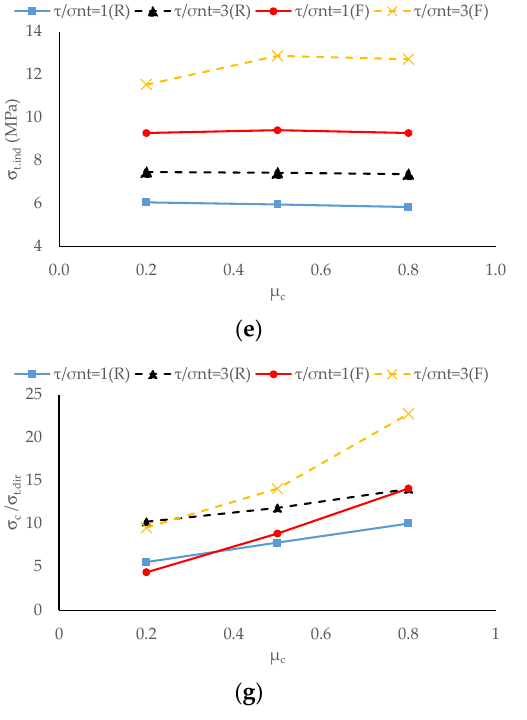
Figure 13. Contact friction properties influence on macroscopic response, Rigid (R) and Flexible (F) numerical predicted response: ( a ) compression strength; ( b ) friction angle; ( c ) cohesion; ( d ) direct tensile strength; ( e ) indirect tensile strength; ( f ) direct to indirect tensile strength ratio and ( g ) compression to direct tensile strength ratio.